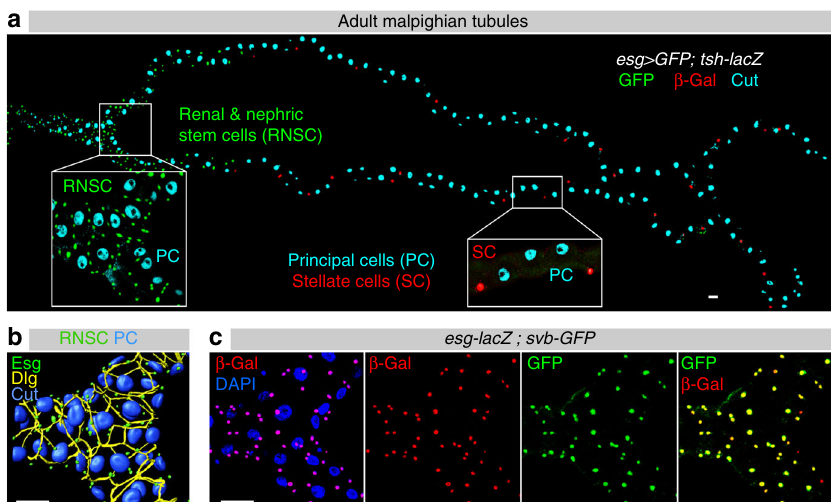
Fig. 1 svb is speci fi cally expressed in renal stem cells. a Adult Malpighian tubules are composed of three types of cells. Principal cells (PC) are identi fi ed by immunostaining against Cut (cyan) and stellate cells (SC) by tsh-LacZ (red). RNSCs, located in the lower tubules, express esg-Gal4 , UAS-GFP (green). b 3D reconstruction of the fork region of Malpighian tubules, with esg-positive RNSCs in green, immunostaining against Discs Large (Dlg) and Cut in yellow and blue, respectively. c Expression of svb and esg as monitored by co-staining for svb - E-GFP (green) and esg-LacZ (red) enhancers, respectively. Nuclei were counterstained with DAPI (blue). Scale bar is 30 µ m